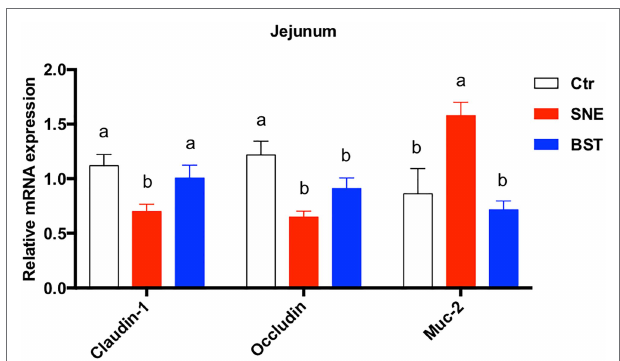
FIGURE 2 | Changes in relative expression of claudin-1 , occluding , and muc-2 in the jejunum. Data are means ± standard error ( n = 6). a,b Mean values within a row with no common superscript differ significantly ( p < 0.05). Ctr group, basal diet in control group; SNE group, basal diet + SNE (20-fold dose coccidiosis vaccine) + 1 ml of Clostridium perfringens (2 × 10 8 cfu/ml coinfection); BST group, basal diet (days 1–21) + 1 × 10 9 colony-forming units (cfu)/kg BS diet (days 22–63) + SNE. Muc-2 , mucin 2 .